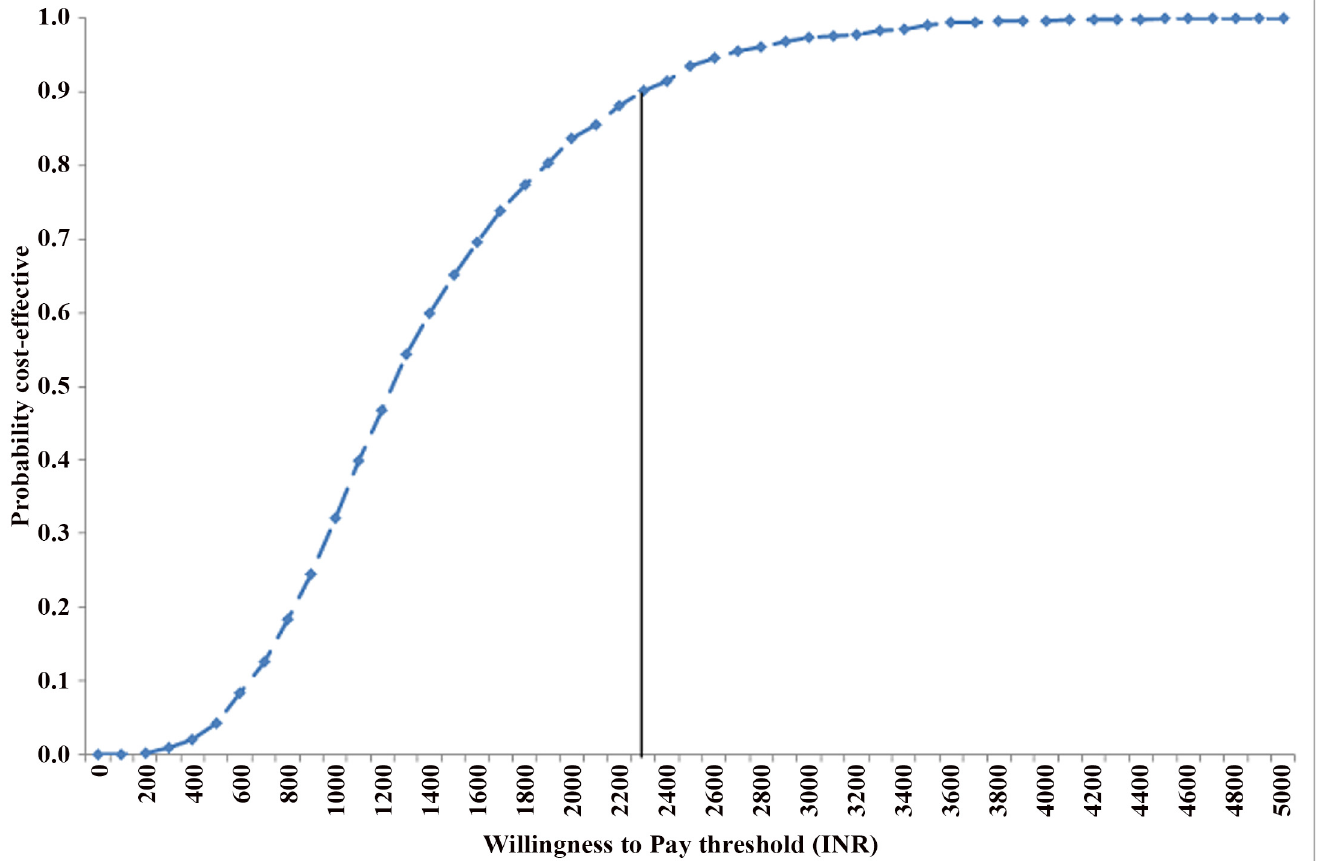
Fig 5. Probability of IMNCI Program to be cost effective at varying willigness to pay thresholds per DALY